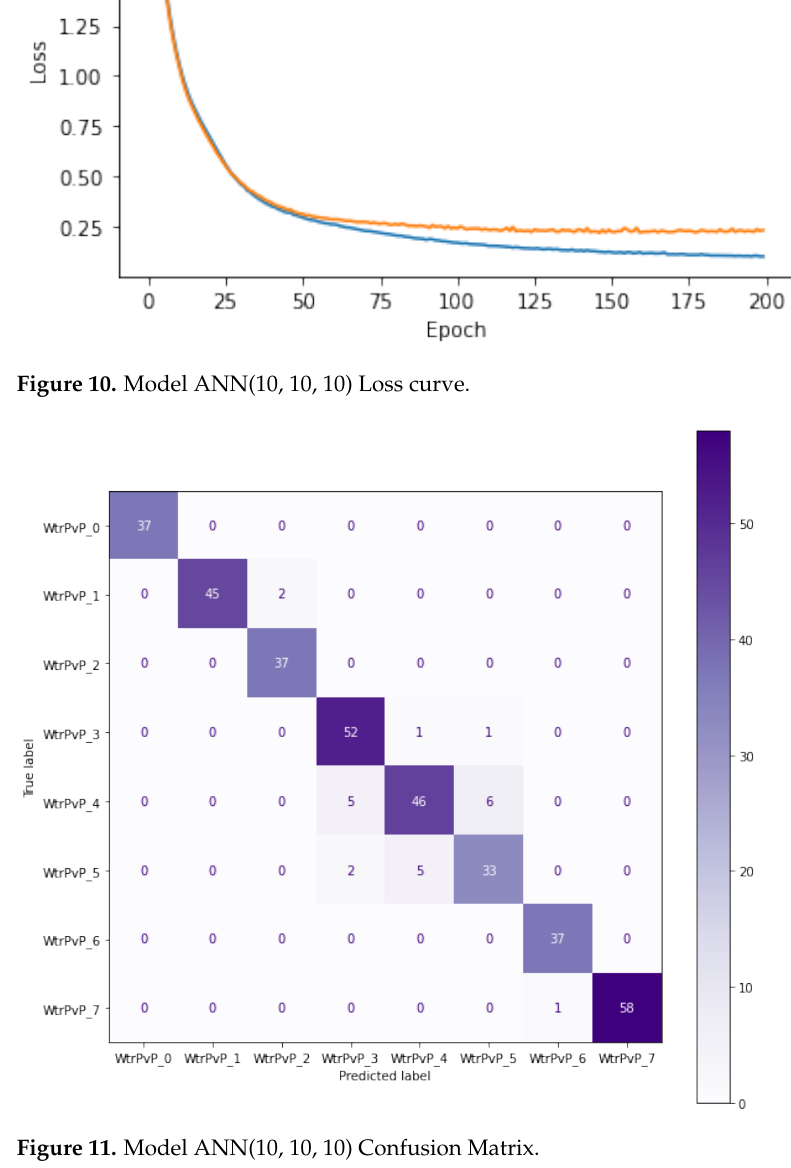
Figure 11. Model ANN(10, 10, 10) Confusion